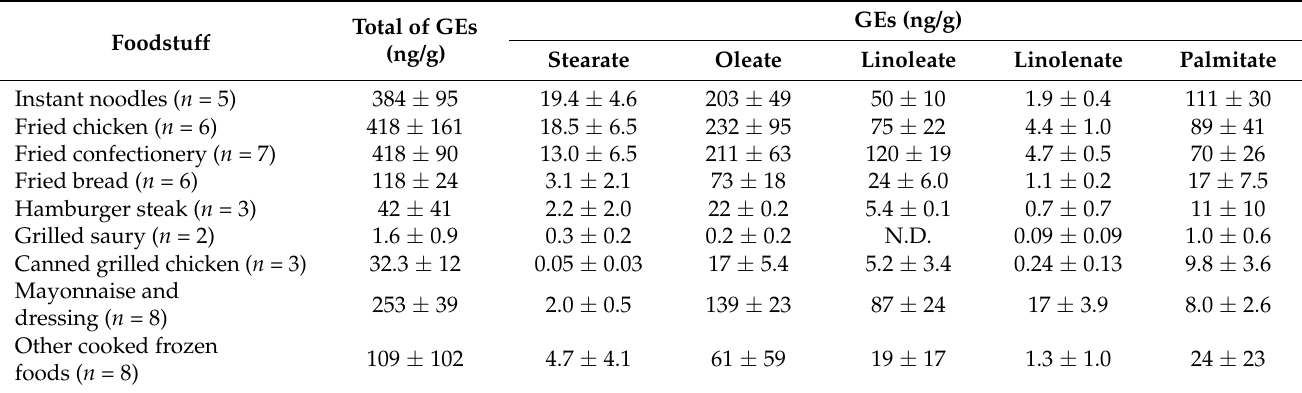
Table 3. Concentration of GEs in food samples from eight food